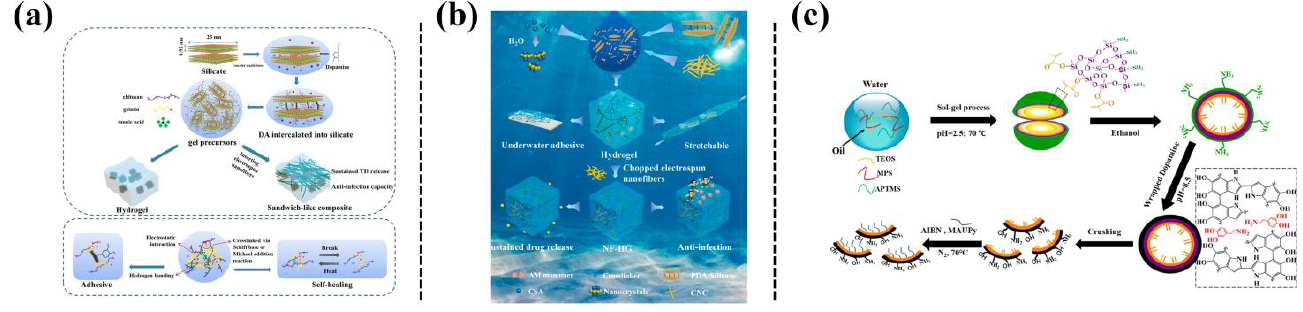
Figure 14. ( a ) The fabrication of multifunctional sandwich-like NF-HG based on polydopamine- intercalated silicate nanoflakes (PDA-Silicate) [83]. ( b ) The formation of an underwater adhesive and stretchable hydrogel by incorporation of PDA-Silicate nanosheets [84]. ( c ) Fabrication of the